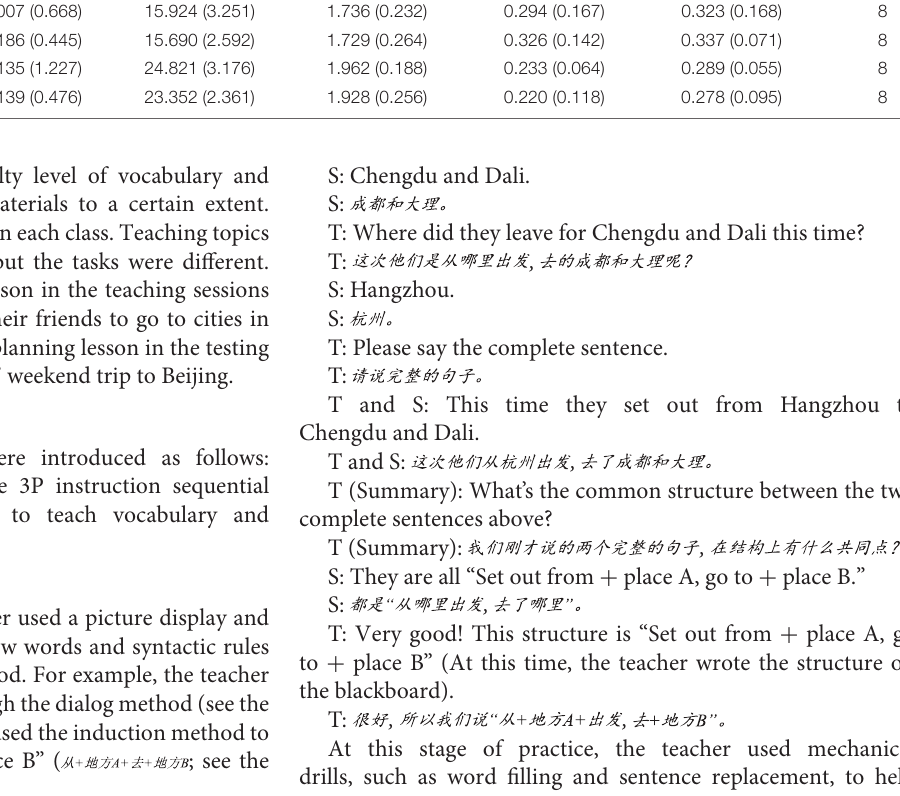
TABLE 2 | Descriptive statistical results for the pretest. Proficiency Instruction